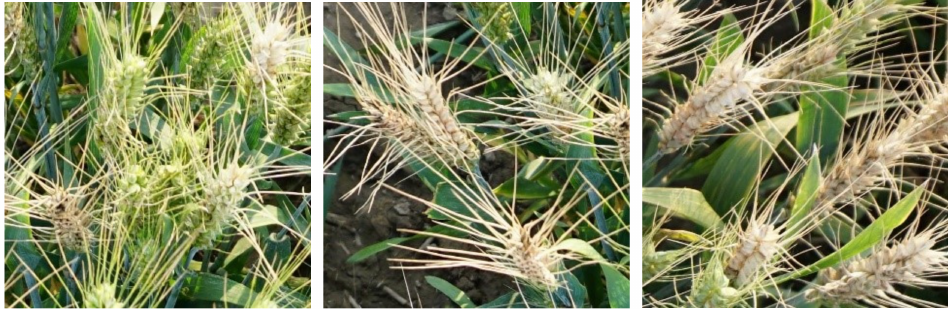
Figure 2. Wheat images infected with